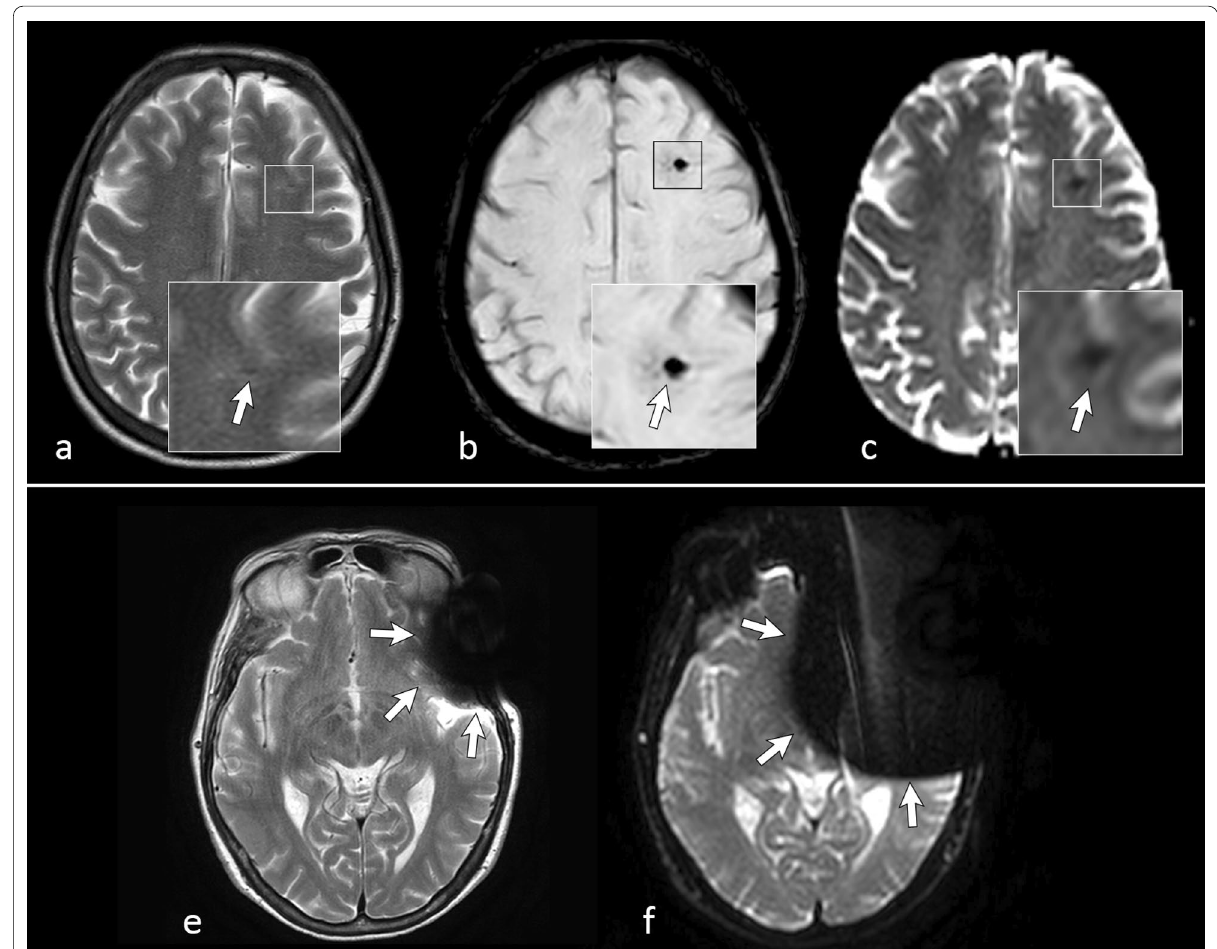
Fig. 16 45-year-old woman with an episode of seizure. On axial turbo spin echo (TSE) T2-w. image a two almost imperceptible areas of linear hypointensity can be noted (arrow shows the most prominent in the parietal lobe). Axial susceptibility weighted imaging (SWI) scan at the same level ( b ) shows evident susceptibility artifacts caused by hemosiderin within small vascular malformations. The same artifacts can also be noted in echo-planar imaging (EPI) diffusion-weighted image with a b-value of zero ( c ). EPI sequence sensitivity to susceptibility artifact is well depicted by comparison between TSE T2-w. e and EPI image ( f ) of the brain in a patient with a ferromagnetic dental